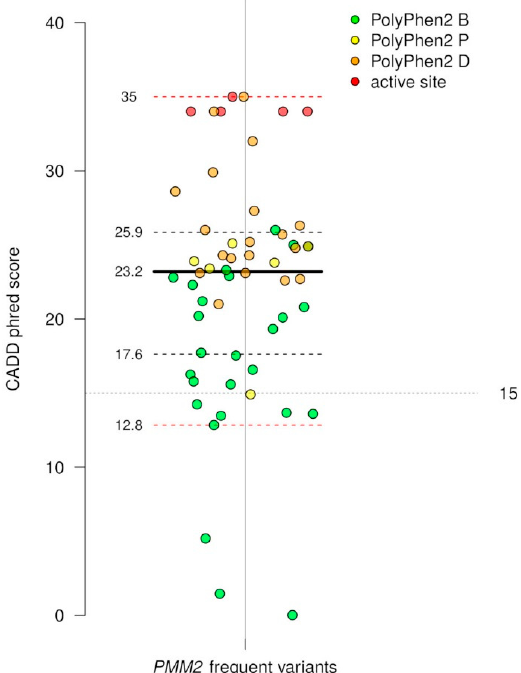
Figure 3. Distribution of CADD scaled scores and PolyPhen2 deleteriousness predictions for PMM2 frequent variants. The medians are indicated by thick black lines; the lower and upper quartiles, representing observations outside the 25–75 percentile ranges, are indicated by dashed black lines; and the relative minimum and relative maximum values are indicated by dashed red lines.